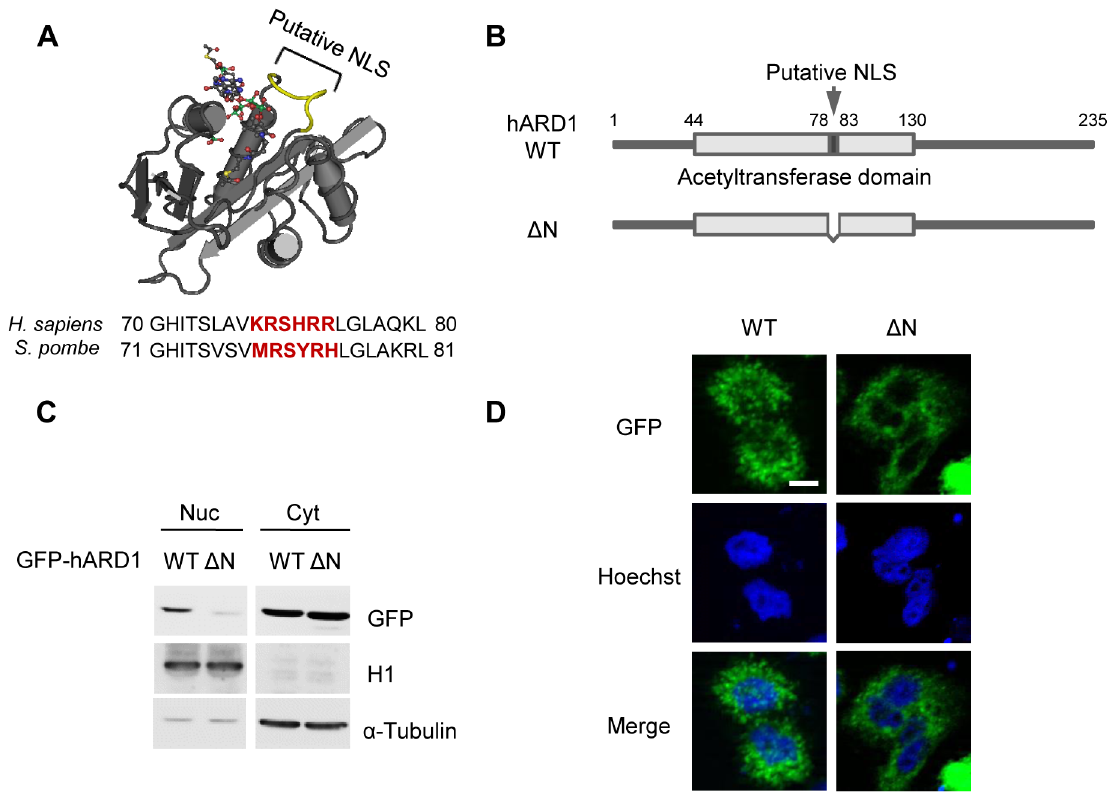
Figure 2. The deletion of the putative NLS of hARD1 blocks nuclear localization. A . The structure and sequence comparison of the putative NLS in ARD1. The reported structure of yeast ARD1 is shown. The region corresponding to the NLS in hARD1 (a.a. 79–84, MRSYRH in yeast [21]) is colored yellow. B . Schematic presentation of an NLS deletion mutant of hARD1. Wild type hARD1 was tagged with GFP at its N-terminus (GFP- hARD1 WT), and the putative NLS was deleted (GFP-hARD1 D N). C . Deletion of NLS compromised nuclear translocation of hARD1. HEK293T cells transfected with GFP-hARD1 WT and D N were subjected to nuclear/cytosolic fractionation and GFP-hARD1 levels were detected by anti-GFP antibody. Note the slight decrease in size of D N relative to WT. D . NLS-deleted hARD1 was unable to access the nucleus. GFP-hARD1 WT- and D N- expressing HeLa cells were visualized by fluorescence microscopy. Scale bar, 10 m m.